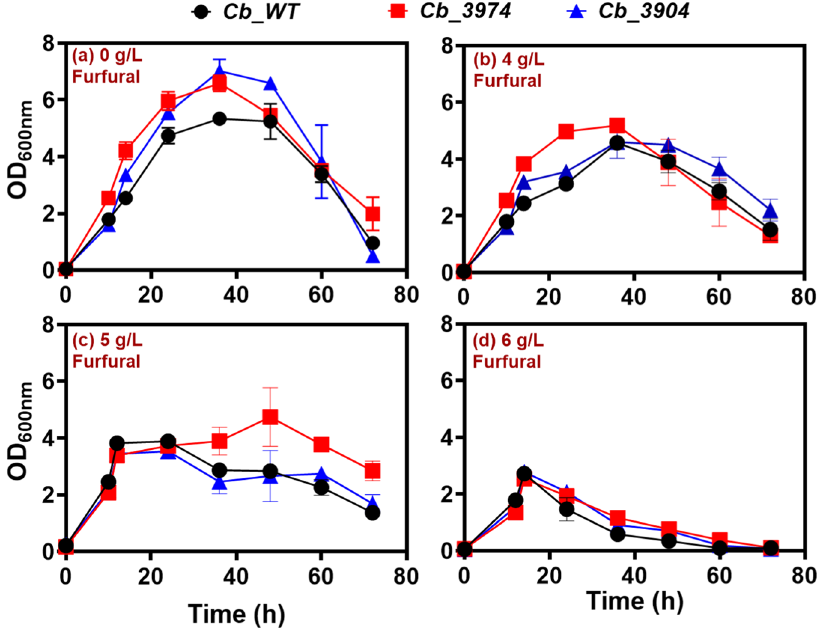
Figure 3. The growth profiles of Cb _3974, _3904 and _wild type in furfural (0–6 g/L)-challenged cultures.